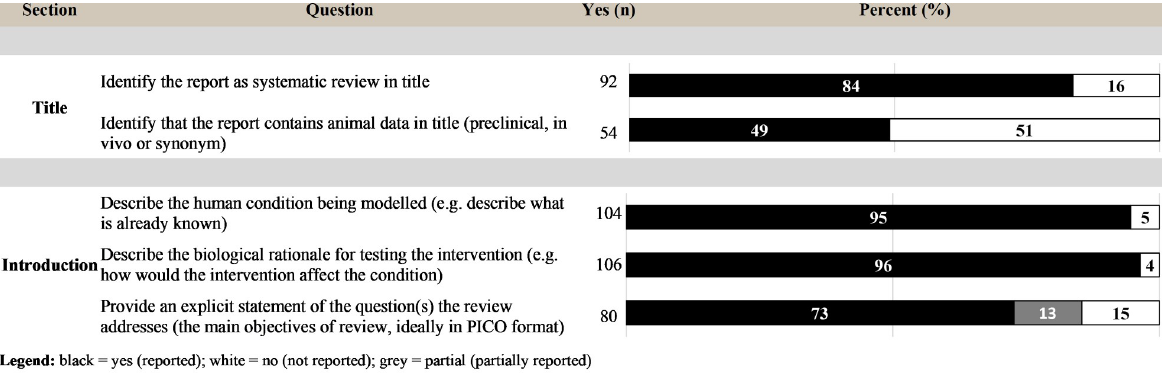
Fig 5. Level of reporting (count and percent) for the items within the title and introduction sections. PICO, population, intervention, comparison, outcome.